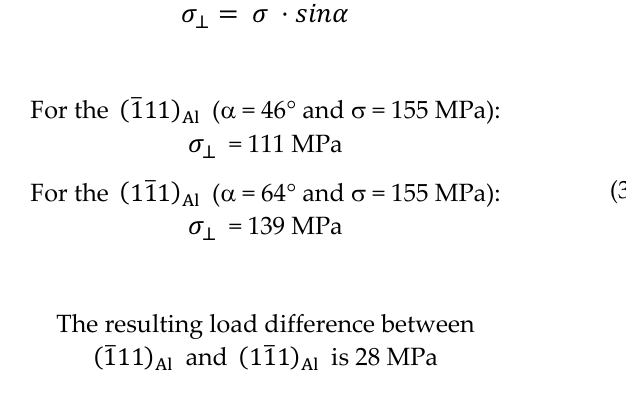
Figure 10. T 1 plates of Creep test 2 (155 MPa, 180 °C, 1002 h): ( a ) Type 2 on (111)  ; ( b ) Type 4 on (1  11)  ; and ( c ) Type 2 on (11  1)  . 3.3.4. Strain Measurements Using GPA To understand the thickening mechanism for T 1 precipitates, different stackings and thicknesses of the precipitates were analyzed with respect to the corresponding strain states. This was done by employing GPA analysis, which provides information on the local displacement in and around the precipitates compared to the (stress free) reference Al matrix. In the following, the strain states for different stacking sequences are presented and used as an indication whether the lattice deformation in and around precipitates correlates to the stacking thickness or the stacking type. Figure 11